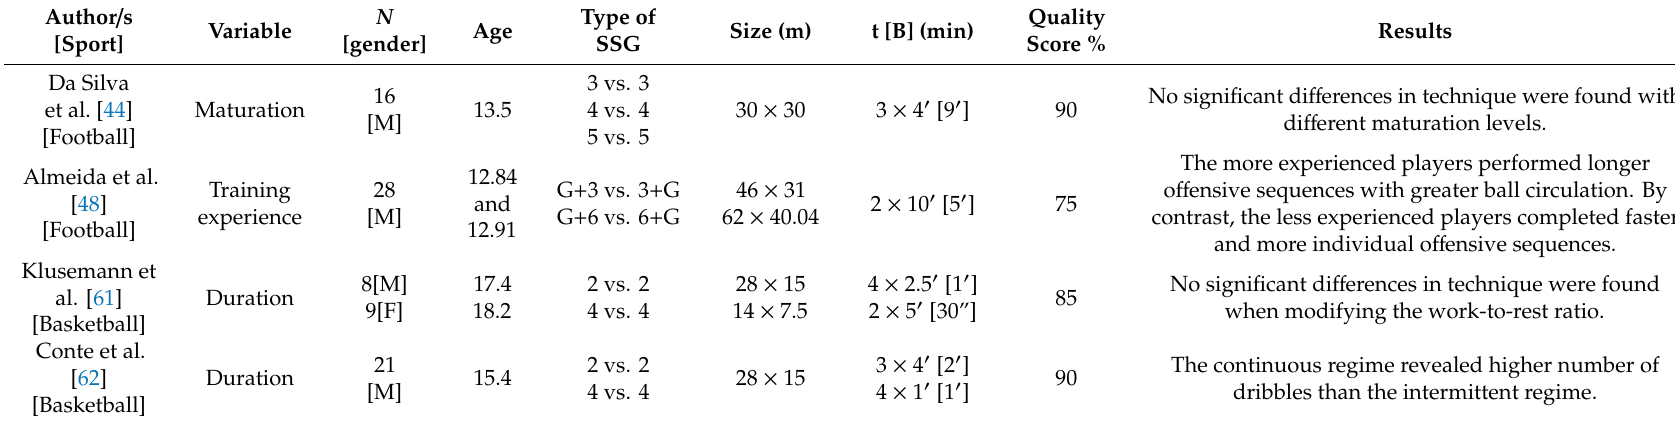
Table 4. E ff ects of other variables of SSGs on technical–tactical